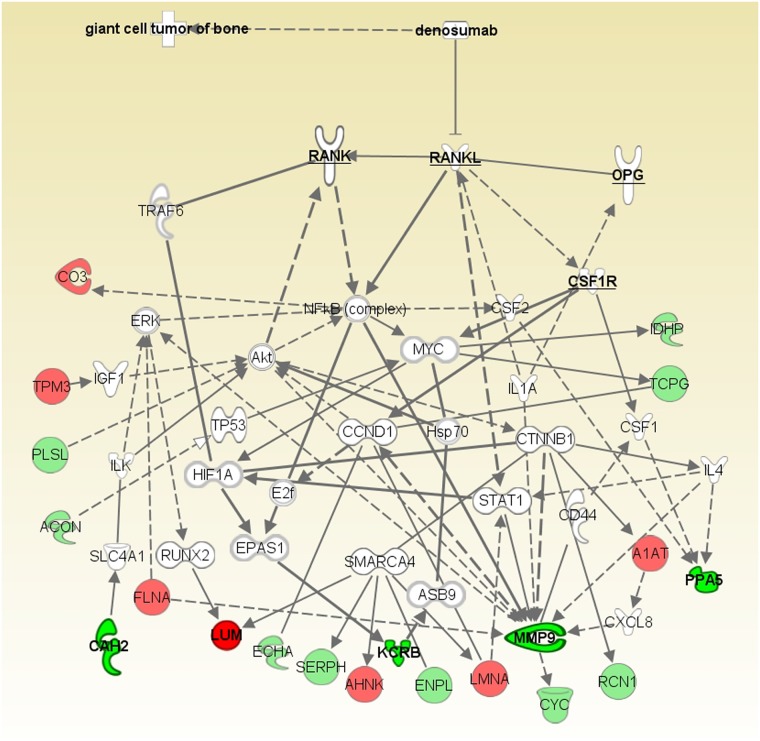
The hypothesized pathway of the effects of denosumab in GCTB based on the data from our proteomic profile.Each protein within the network is shown as a node. The lines indicate the interactions between the nodes. The nodes that were identified as being upregulated or downregulated in the proteomic profiles are indicated in red or green, respectively.